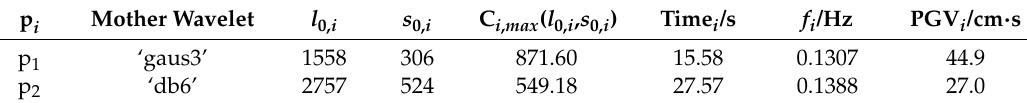
Figure 9. The time–frequency plane for the extracted pulse components at station TCU101: ( a ) p (cid:2869) with the guas3 mother wavelet, and ( b ) p (cid:2870) with db6 mother wavelet. Table 1. The parameters for the extracted pulse components at station TCU101.